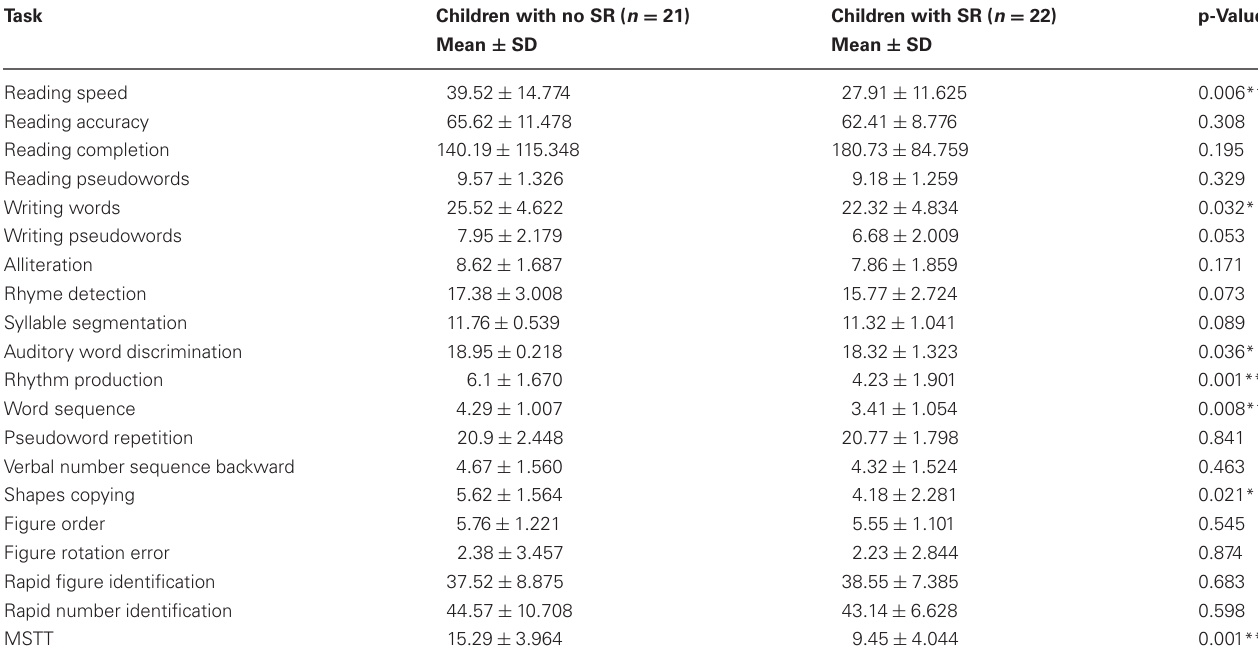
Table 1 | Descriptive characteristics (mean ± standard deviation) of performance on cognitive-linguistic measures and MSTT in children who exhibited at least one occurrence of SR are compared to children with no